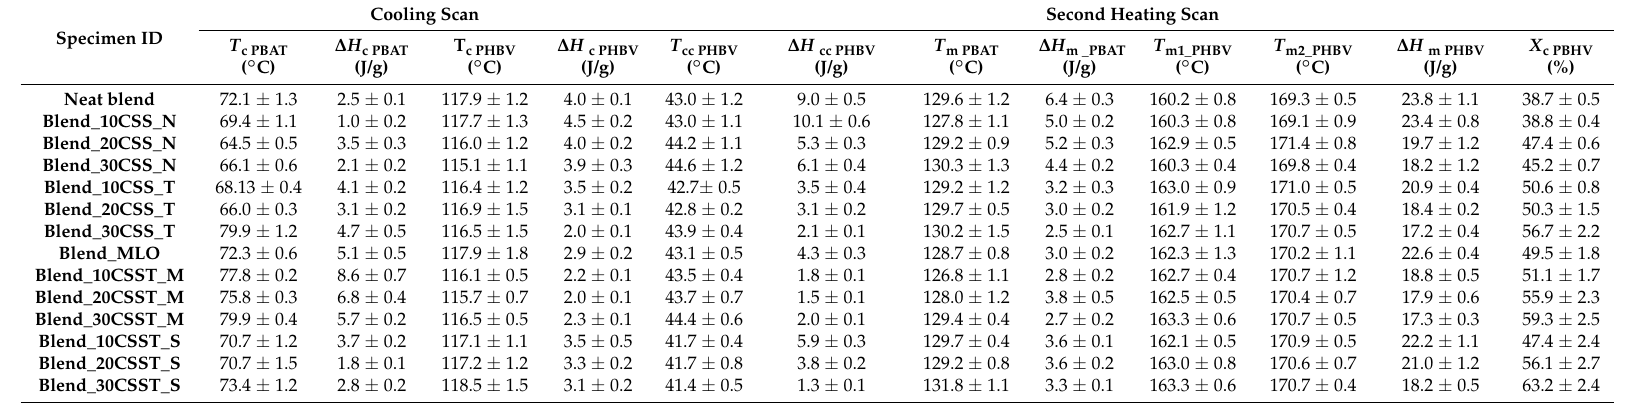
Table 3. Differential scanning calorimetry (DSC) results of PBAT/PHBV blend-based